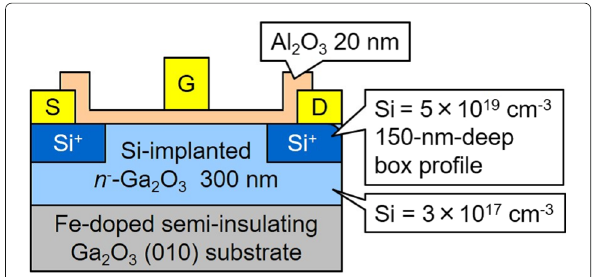
Fig. 10 Schematic cross section of D-mode Ga 2 O 3 MOSFET. Adapted with permission [87]. Copyright 2013, IEEE